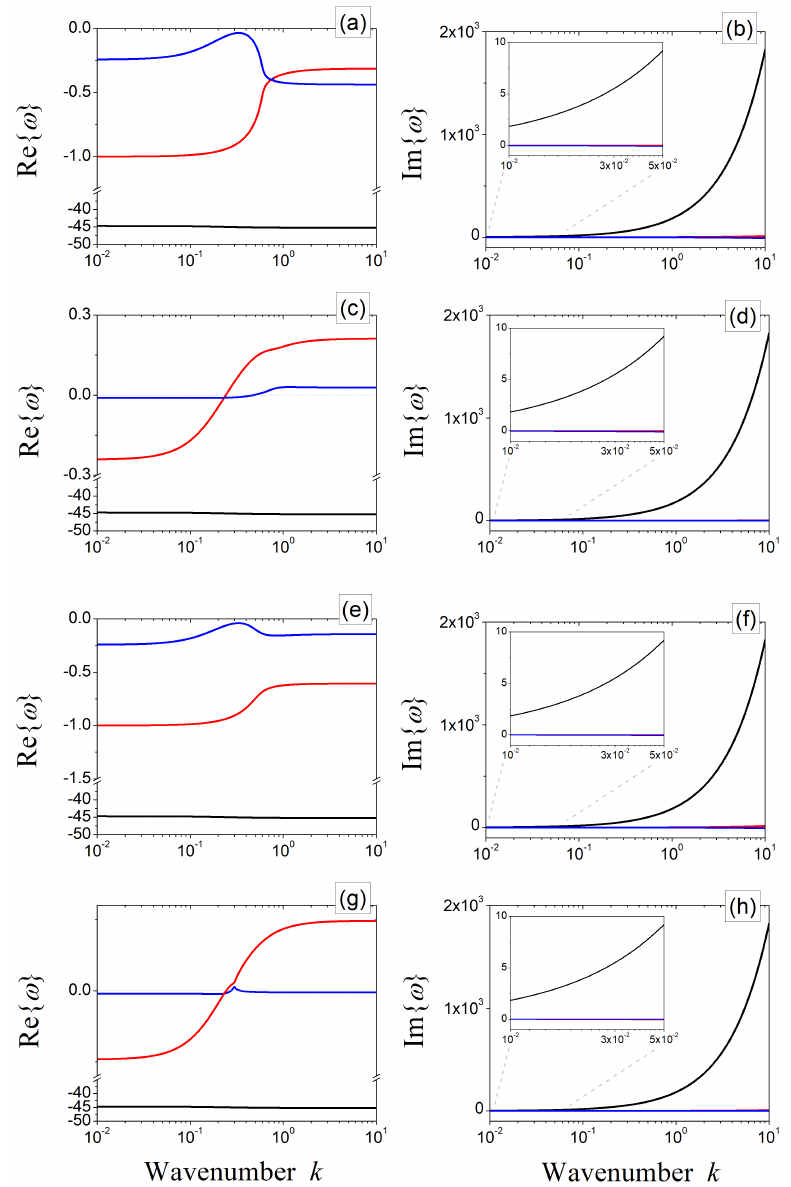
Figure 2. Real (left panels) and imaginary (right panels) parts of the roots ω 1,2,3 of the characteristic polynomial (6) as a function of the wavenumber, obtained for ψ = 0.2 [panels ( a – d )] and ψ = 0.8 [panels ( e – h )]. Panels ( a , b , e , f ) correspond to the point P 1 , whereas ( c , d , g , h ) correspond to P 2 . Blue, red, and black lines are representative of ω 1 , ω 2 , and ω 3 , respectively. Fixed parameters: A = 1.7 and B =